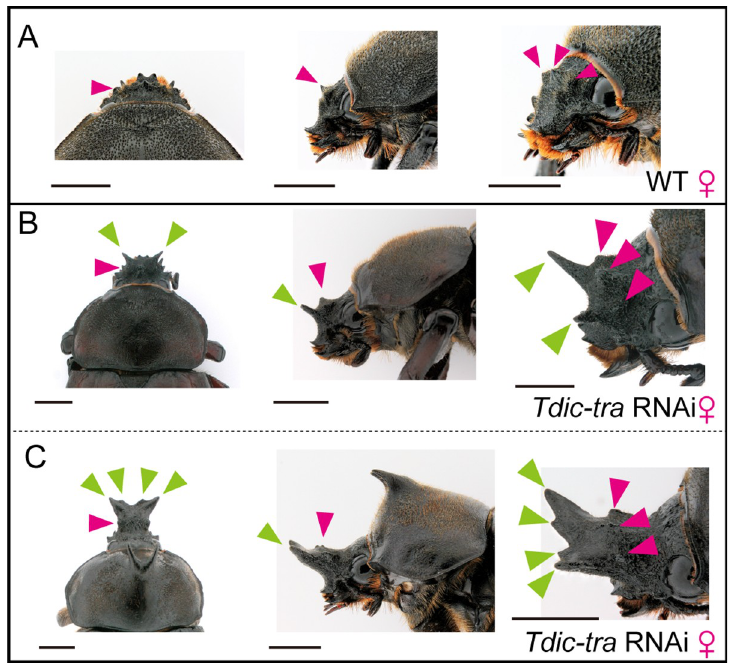
Fig 6. Horn formation phenotypes induced by Tdic-tra RNAi at late prepupal stages. (A-C) Comparison of wild type female head and ectopic intermediate sexual transformation head horn in female heads induced by Tdic-tra RNAi treatments. (A) A wild type female head. (B) Small ectopic head horn formation in a female head. (C) Middle-sized ectopic head horn formation in a female head. Three small protrusions are formed in clypeolabrum on the wild type female head (A-C, magenta arrowheads), whereas ectopic small- or middle-sized ectopic head horns were formed in the region anterior to the three small protrusions (B, C, green arrowheads) in Tdic-tra RNAi treatments. Scale bars are 5